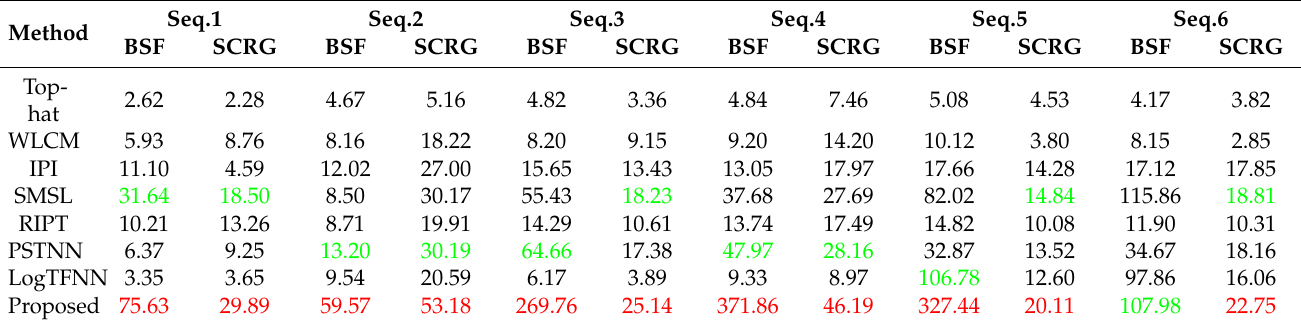
Table 4. The BSF and SCRG results for the six sequences by eight methods.